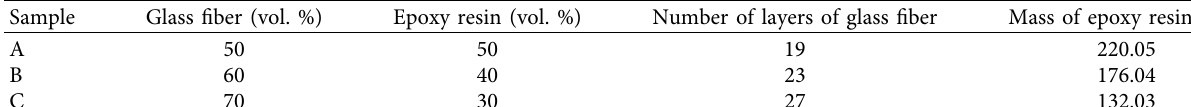
Table 1: Details of the fabricated composites.